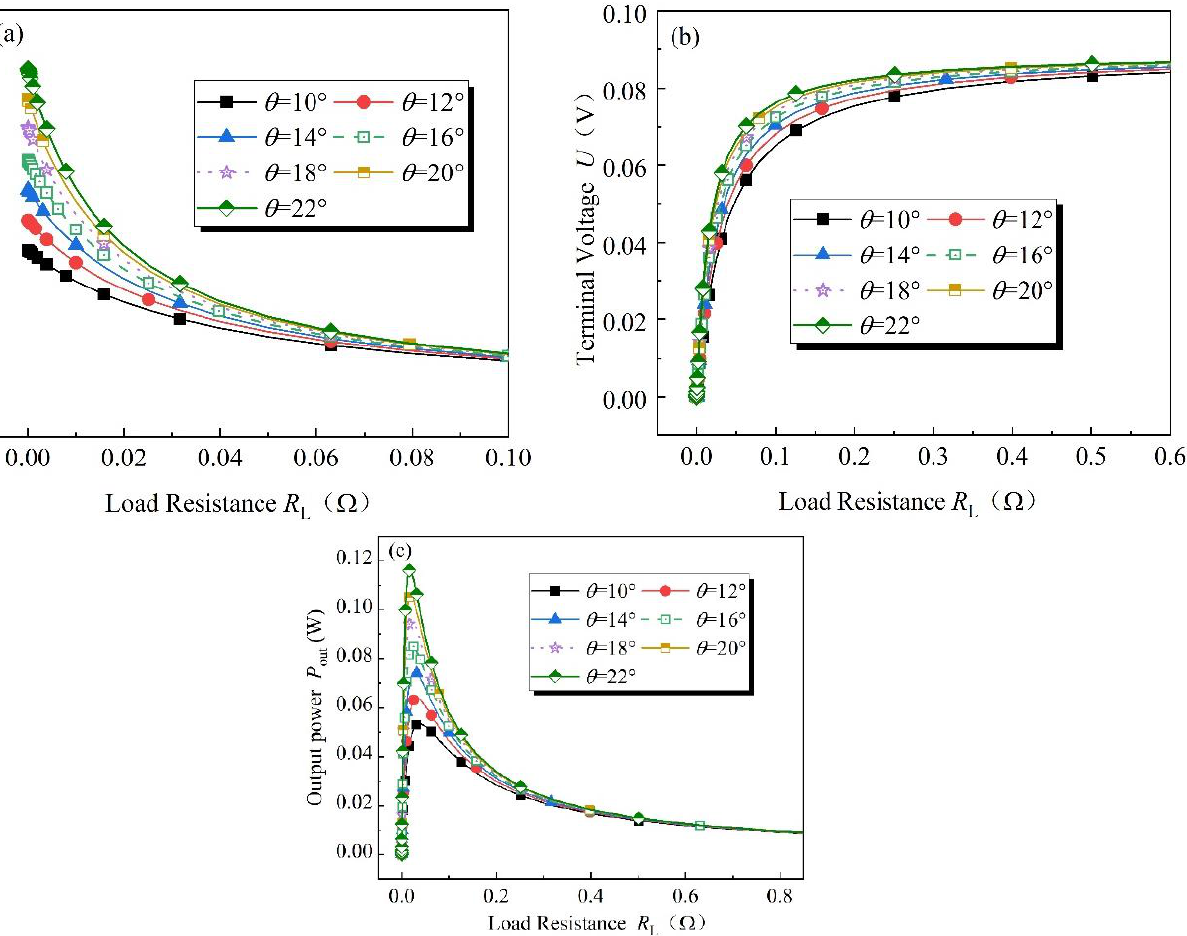
Figure 4. ( a ) The relationship between current and resistance load; ( b ) terminal voltage and re- sistance load; and ( c ) output power and resistance load. load; and ( c ) output power and resistance